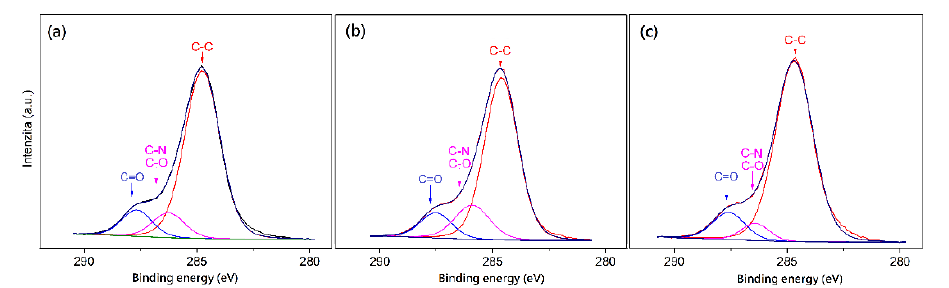
Fig. 3. The deconvolution of the C 1s peak from XPS spectra of (a) pristine PA6, (b) modified PA6 nanofibers with the ion implantation fluence 1.8×10 14 cm -2 and (c) modified PA6 nanofibers with the with ion implantation fluence 5.6×10 14 cm -2 .